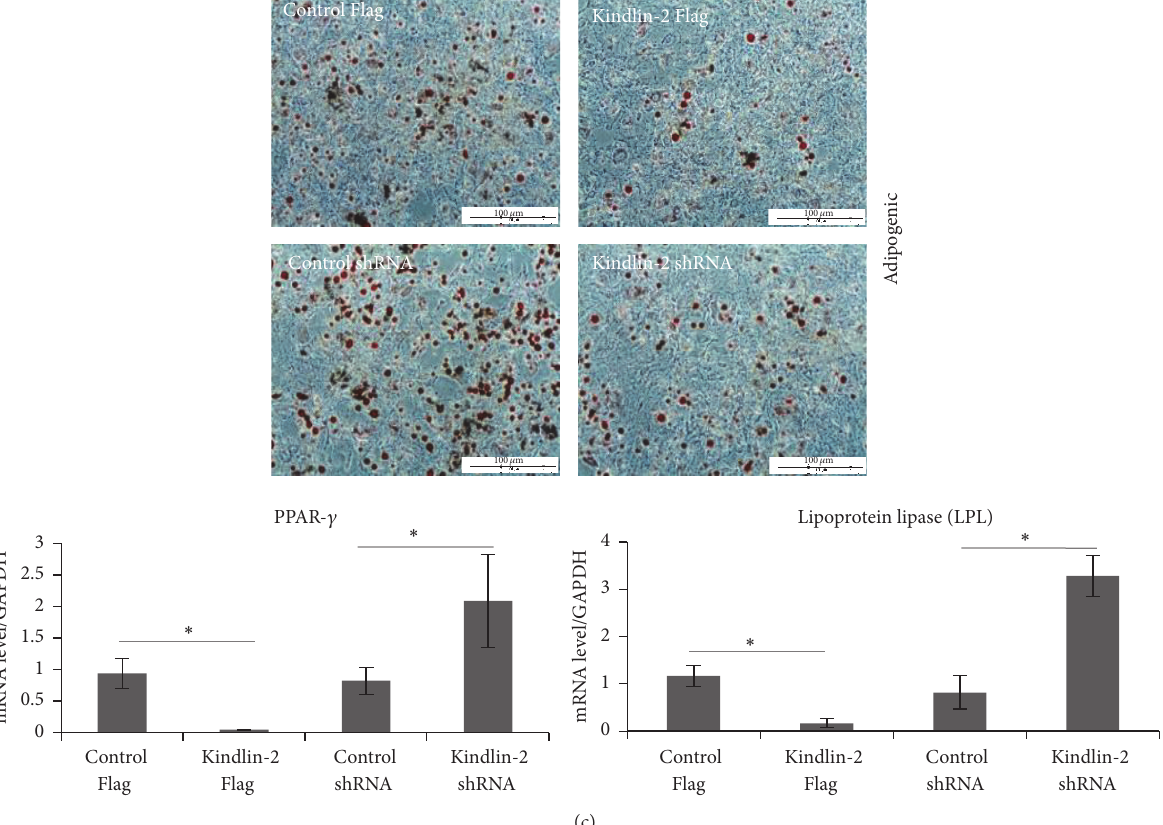
Figure 4: Differentiation capacity of iPSC-MSCs after Kindlin-2 transfection. Osteogenic, chondrogenic, and adipogenic differentiation potential of hiPSC-MSCs after transfection with constructs modulating Kindlin-2. Alizarin Red staining for mineralized deposits (a), Alcian Blue staining for chondrocyte pellets (b), and Oil Red-O staining for lipid formation (c) formed by the three iPSC-MSC cell lines. The mRNA expression level of the relative expression of genes associated with osteogenesis (osteocalcin and alkaline phosphatase), chondrogenesis (collagen type II and aggrecan), and adipogenesis (PPAR- 𝛾 and LPL). The data represent the mean expression values normalized to the housekeeping gene GAPDH. Magnification is 10x. ∗ Significance difference 𝑝 ≤ 0.05